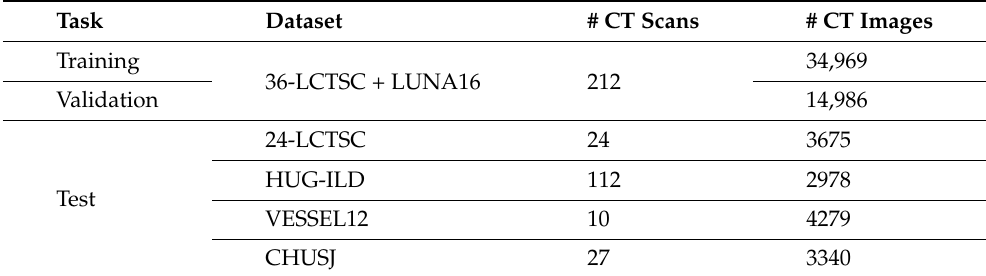
Table 3. Distribution of the data per training, validation, and test